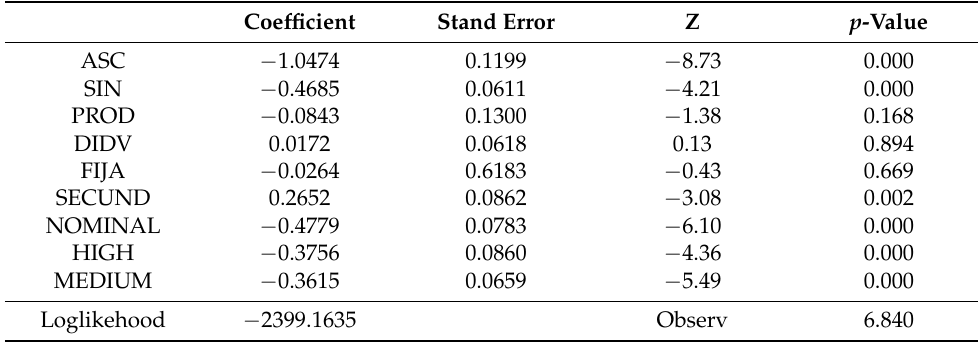
Table 3. Results of the choice